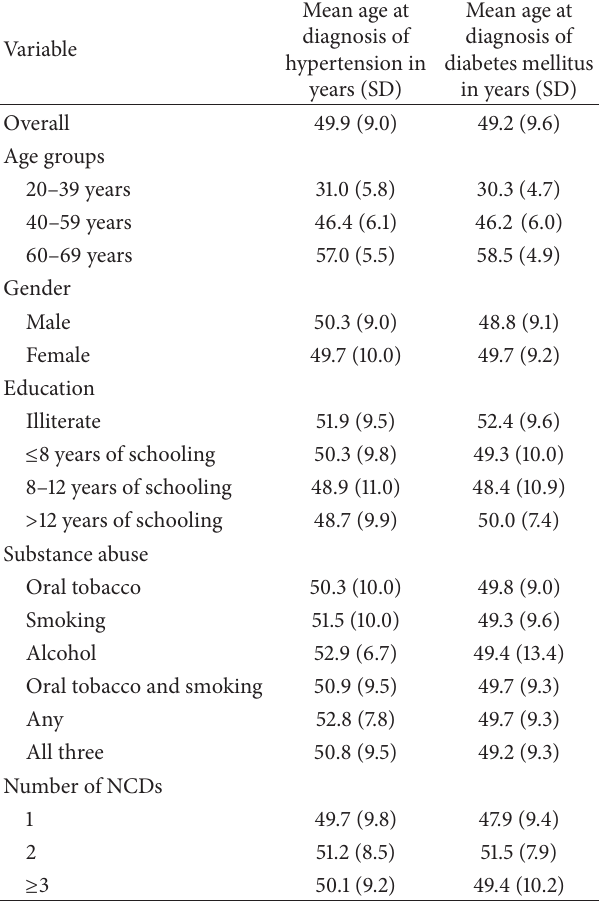
Table 6: Self-reported age at diagnosis of hypertension and diabetes mellitus in adults (20–69 years) with respect to various sociodemo- graphic